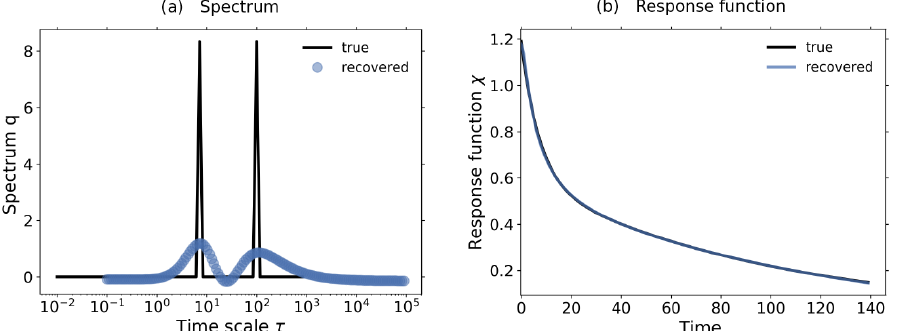
ter resolution. Therefore, we take M = 140. All other RFI parameters are taken according to Part 1. Also,